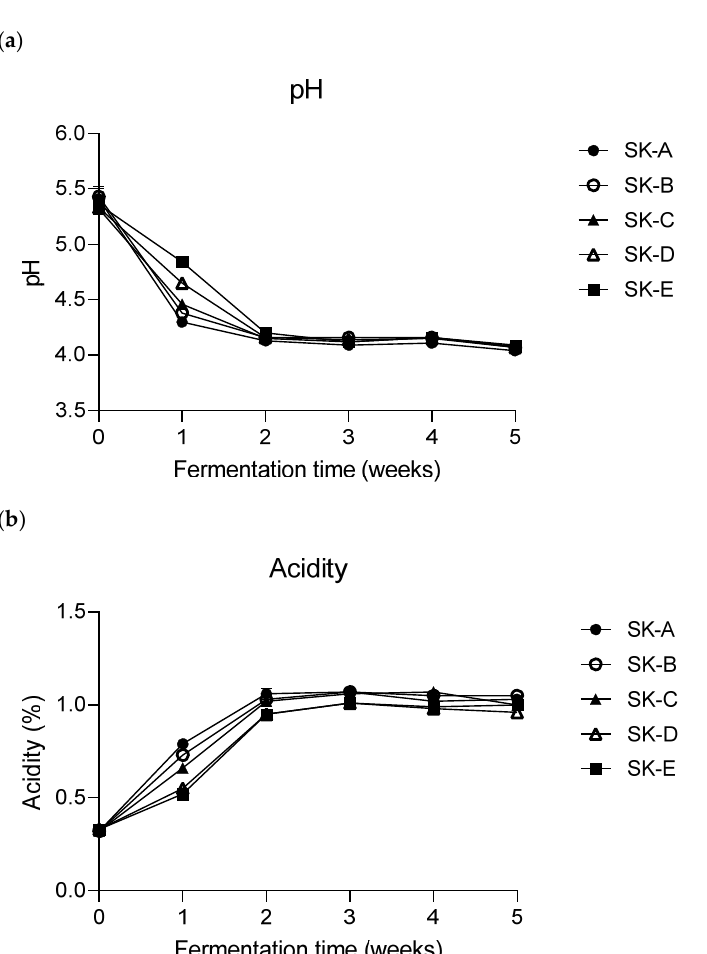
Figure 2. Changes in the pH ( a ) and acidity ( b ) of kimchi samples with different salinities during fermentation.